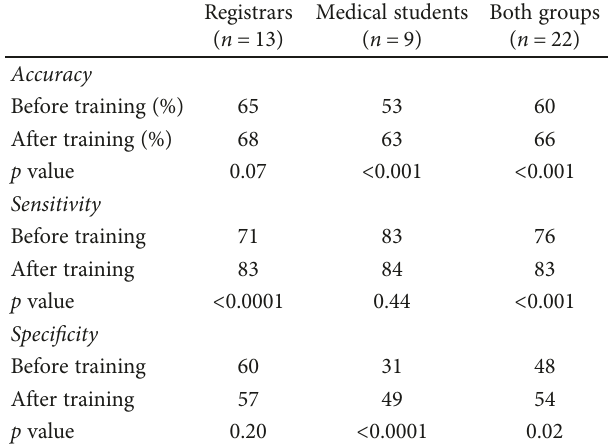
Table 2: Accuracy, sensitivity, and speci fi city amongst both groups on non-experts before and after web-based